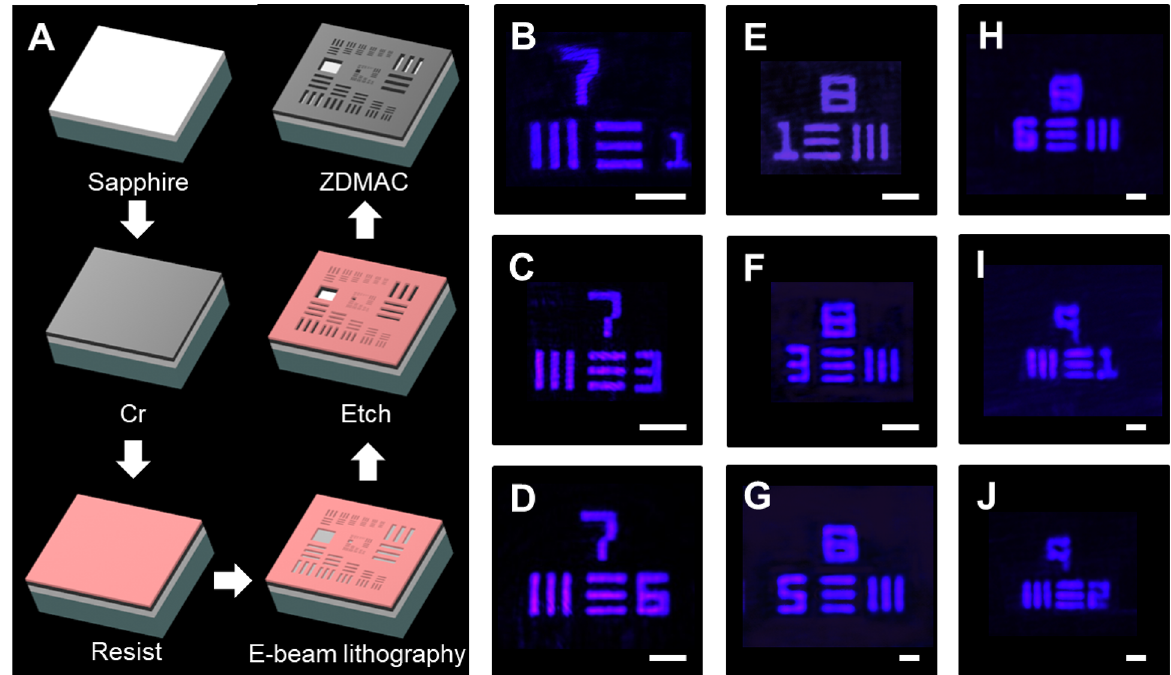
Figure 4. Imaging with the metalenses. ( A ) Fabrication of the 1951 USAF resolution test chart. ( B – J ) Images of the 1951 USAF resolution test chart formed by the metalenses at the laser wavelength of 405 nm. The smallest features are ( B ) line widths of 3.91 µm and center-to-center distances of 7.82 µm, ( C ) line widths of 3.1 µm and center-to-center distances of 6.2 µm, ( D ) line widths of 2.19 µm and center-to-center distances of 4.38 µm, ( E